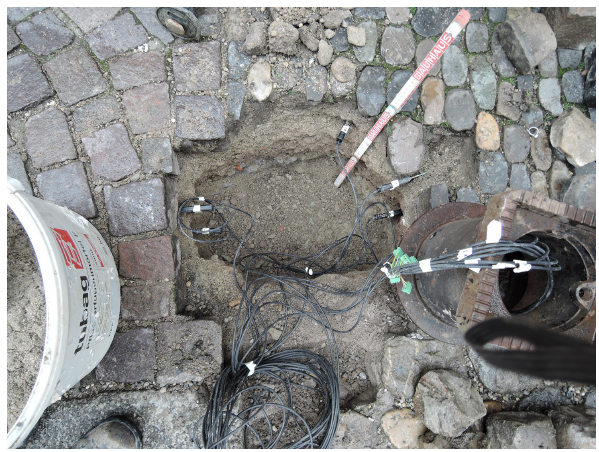
Figure 4. Installation of the soil moisture sensors at the plots of cluster D and the small manhole used for accommodating the data